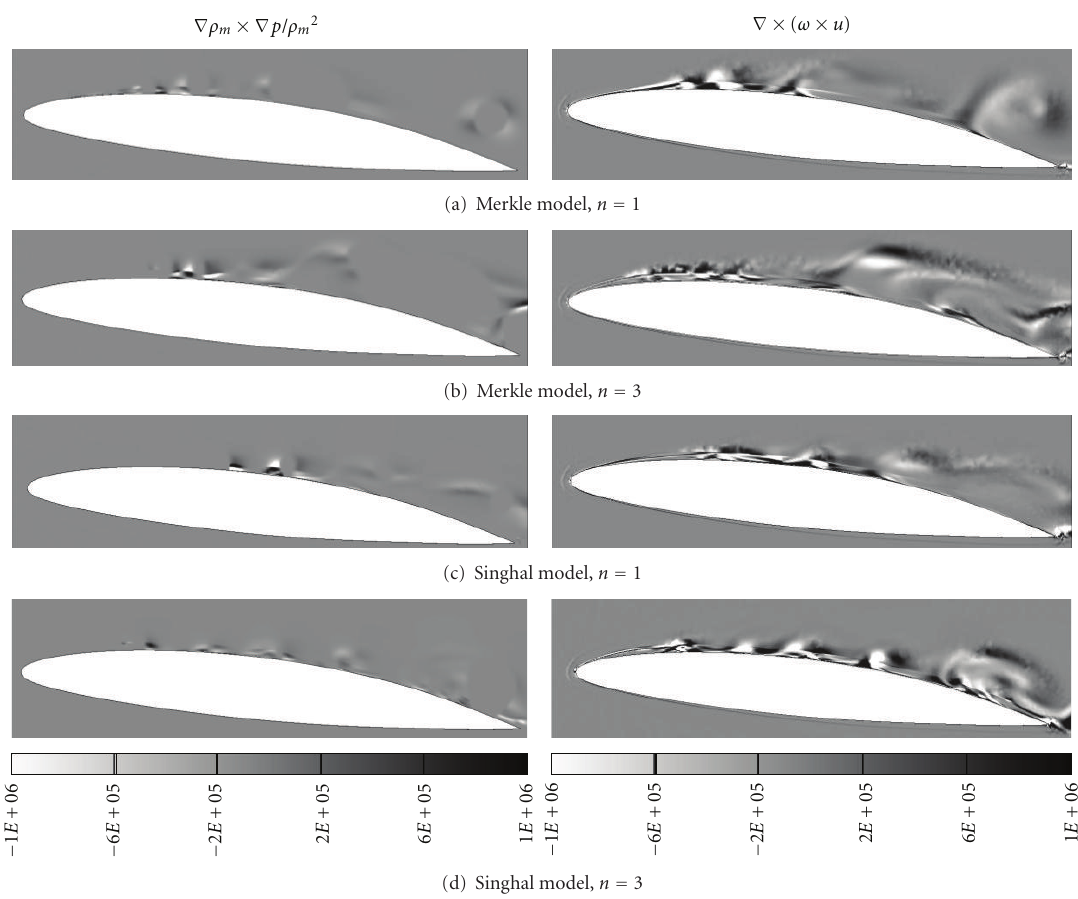
Figure 12: Comparison of the baroclinic torque (left) and vorticity transport/stretching term (right) in (12) at t 6 for the Merkle and Singhal models with n = 1 and 3 for σ = 1, Re = 750,000, V ∞ = 5m/s, and α = 6 ◦ .